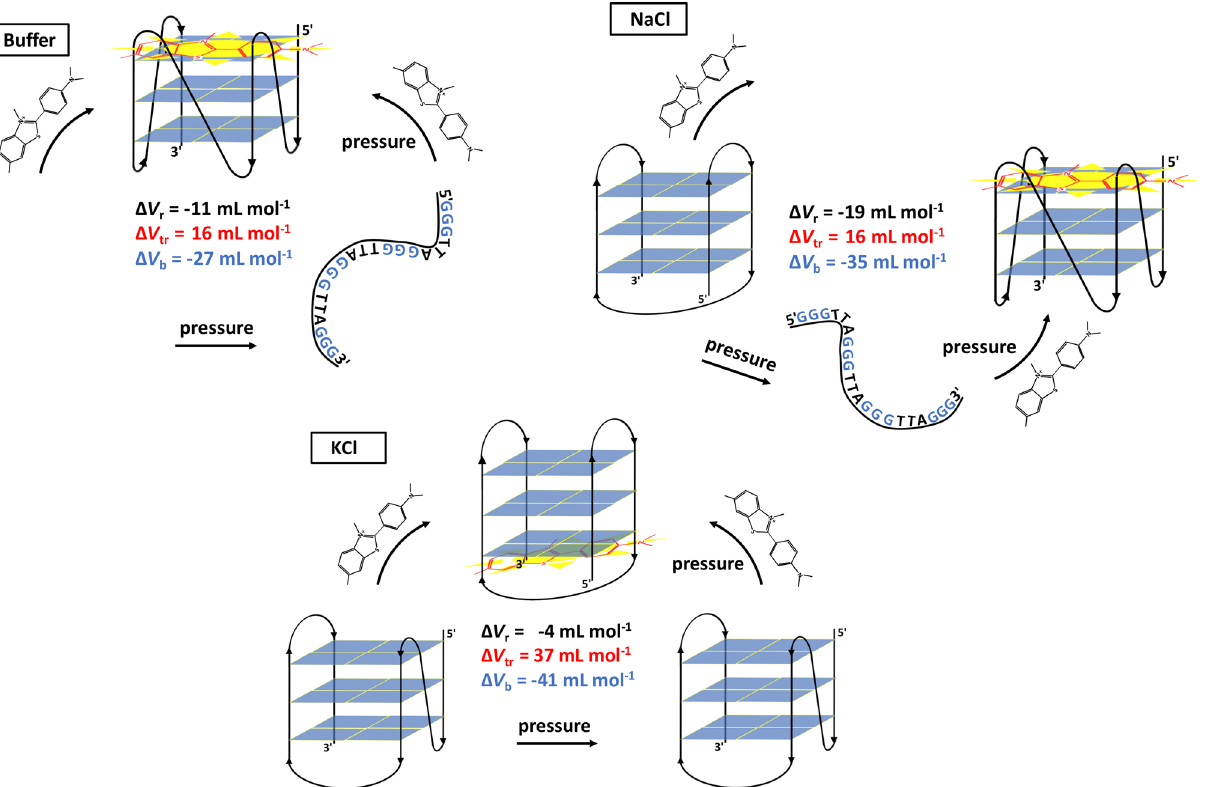
Figure 6. Schematic representation of the effect of different solution conditions (pure buffer and different salts (60 mM NaCl, KCl)) and pressure on the conformation of the 22AG quadruplex in the absence and presence of the ligand ThT. Owing to the complexity of the system, no sketch of the Ficoll data are shown here. For sake of clarity, the possibility of multiple binding modes (as mainly occurring at high pressures) is not taken into account in this schematic, only one representative binding site is shown here. The (apparent) volume changes for the overall reaction (Δ V r ) and tentative values of the ThT binding step (Δ V b ) and the conformational transitions (Δ V tr ) of the GQ are also